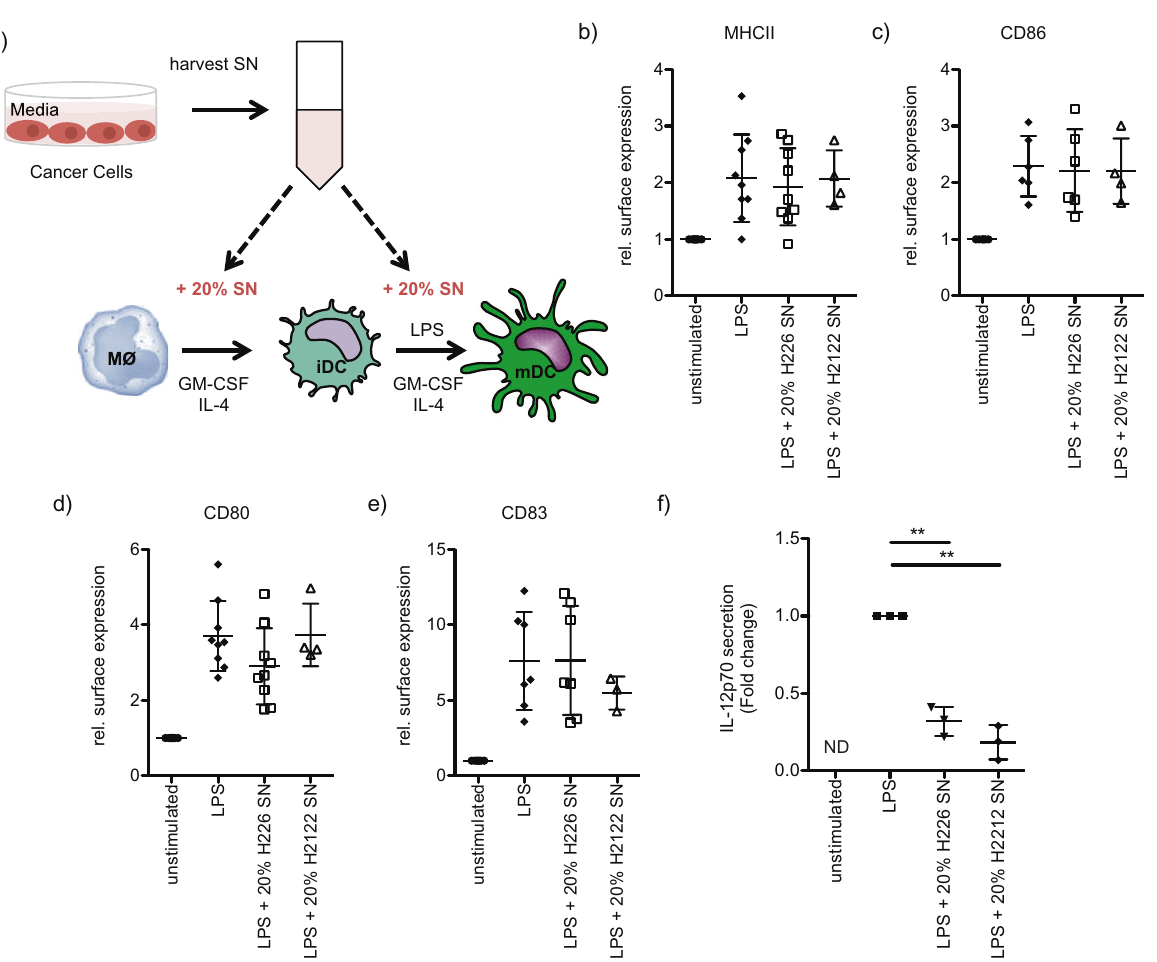
Fig. 1 Impaired IL-12p70 secretion of human moDCs treated with cancer cell supernatant. a Schematic illustration of the experimental setup. Human moDCs were obtained through culturing monocytes with GM-CSF/IL-4 for 5 days. During the differentiation, cells were optionally treated with 20% of NCI-H226 supernatant (SN) or 20% of NCI-H2122 supernatant (SN). Immature moDCs (day 5 of culture) were stimulated for 48 h with LPS (100 ng/ml) in the corresponding medium. b – e Surface marker expression ( b , MHCII, c , CD86, d , CD80 and e , CD83) was investigated by fl ow cytometry and the relative mean fl uorescence of multiple independent experiments was quanti fi ed (mean fold change ± SD; Samples with 20% H226: MHCII: n = 9; CD86: n = 6; CD83: n = 7; CD80: n = 9; Samples with 20 % H2122 SN: MHCII: n = 4; CD86: n = 4; CD83: n = 3; CD80: n = 4). f moDCs were treated as described in a) and IL-12p70 secretion was studied by ELISA (mean fold change ± SD, n = 3, ND = not